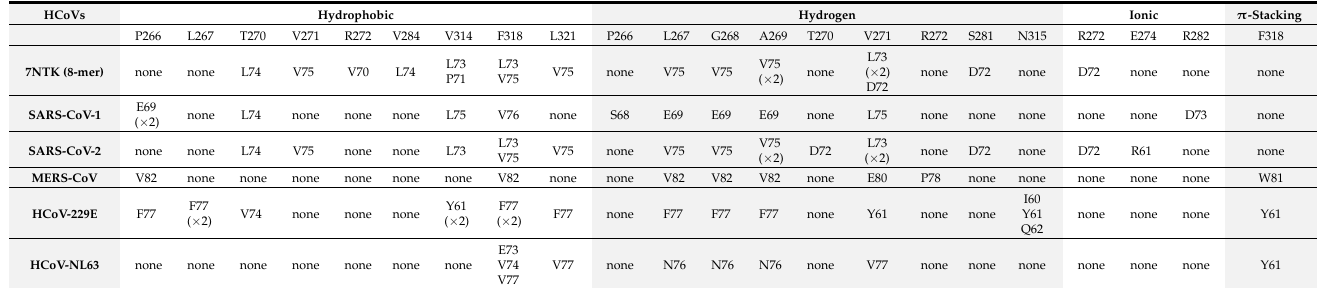
Table 2. Types of interactions that occurred between the docked 18-mer hCoV E peptides and the PDZ domain of the PALS1 protein. The PALS1 PDZ domain residues to which the docked hCoV E peptides bound are shown at the top (second row) along with the corresponding PBM residue(s) of each docked hCoV E peptide. Residues are grouped according to the type of interaction that forms between